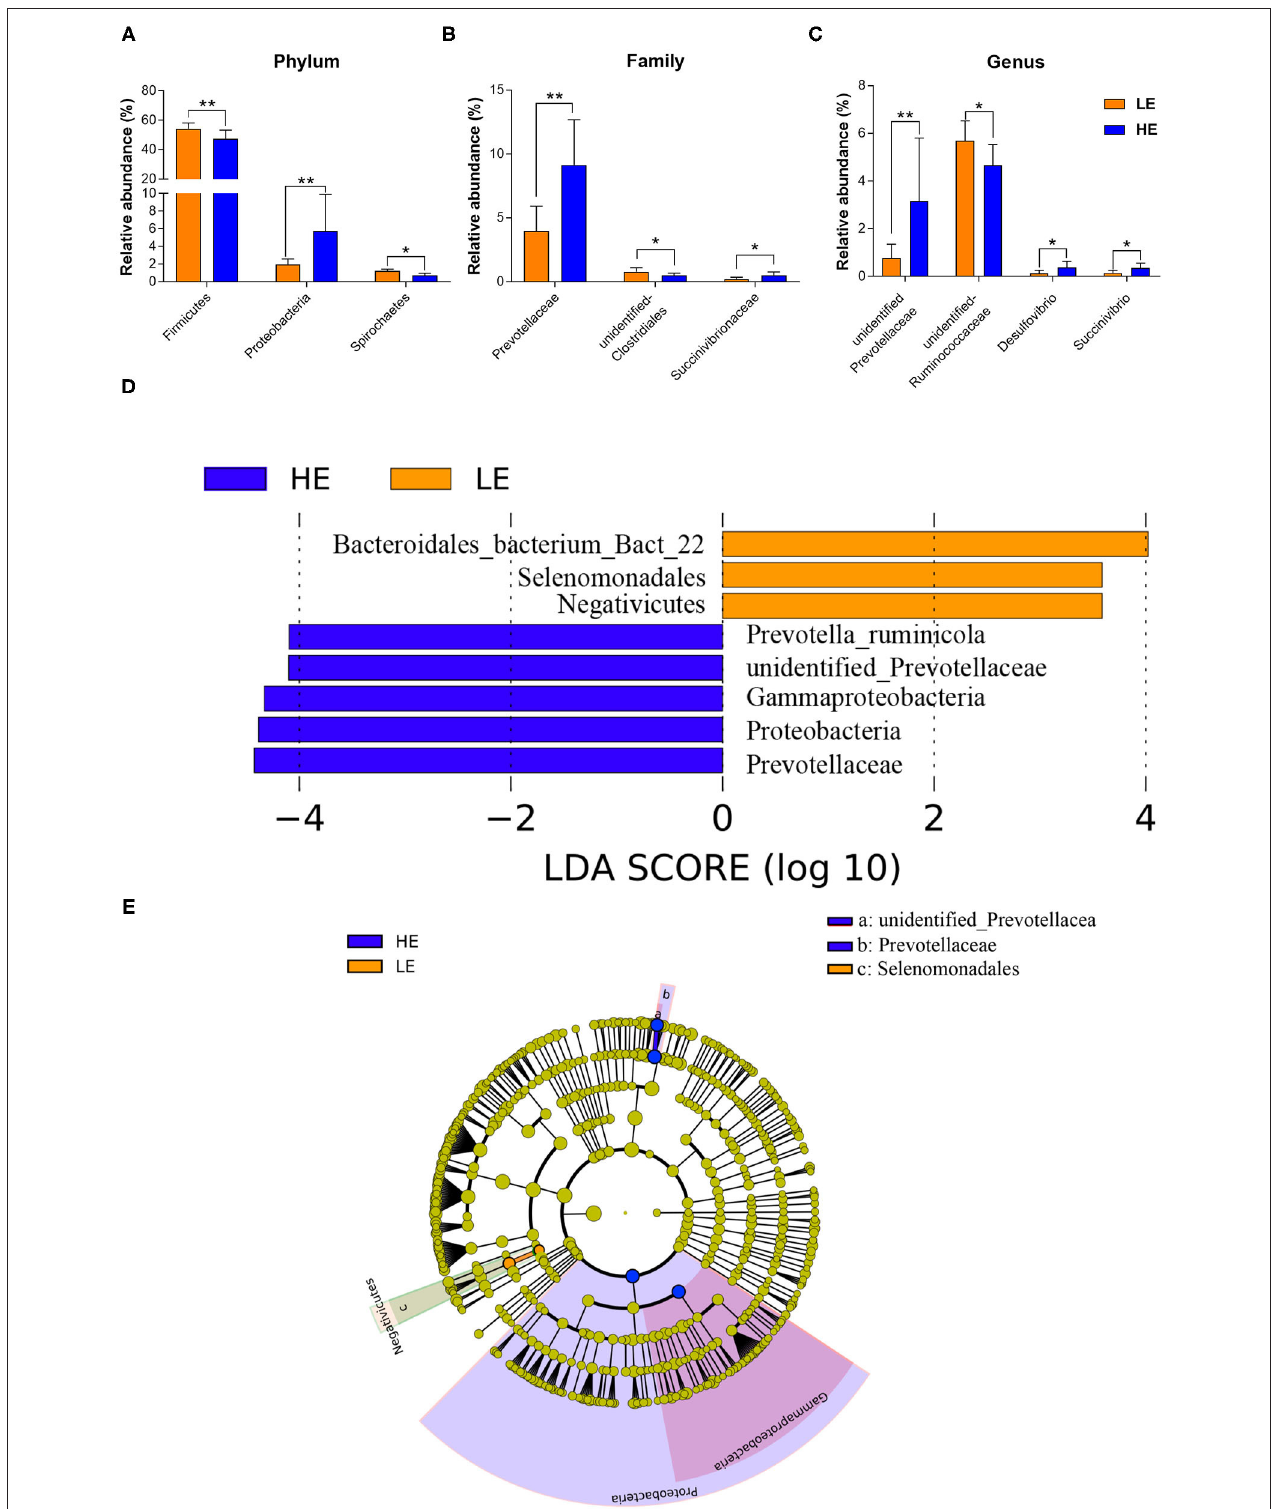
FIGURE 2 | The relative abundances of rectal microbiota that was significantly different between the LE and HE groups at the (A) phylum, (B) family, and (C) genus levels. Only microbes that had a relative abundance of more than 0.1% were compared. Linear discriminant analysis (LDA) value distributed histogram and cladogram of different microorganisms (LDA score > 3.5). (D) Linear discriminant analysis (LDA) value distributed histogram. (E) Cladogram constructed to visualize the microbial community relative abundance data at rectum samples between the LE and HE groups. Difference was declared to be statistically significant when * P < 0.05, ** P <